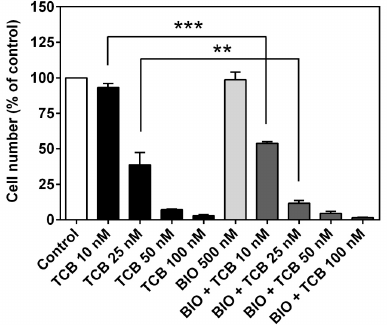
Figure 13. Effect of GSK-3 β inhibition on cell proliferation of LLC-PK1 cells treated with telocinobufagin (TCB). Serum-starved LLC-PK1 cells were treated with 10, 25, 50 and 100 nM TCB in 2.5% FBS for 72 h with or without 500 nM BIO (GSK-3 β inhibitor). Trypan blue-free viable cells were counted in Neubauer chamber. Data are the mean ± SEM of at least three independent experiments in duplicate. ** p < 0.01 vs. TCB 25 nM; *** p < 0.005 vs. TCB 10 nM.